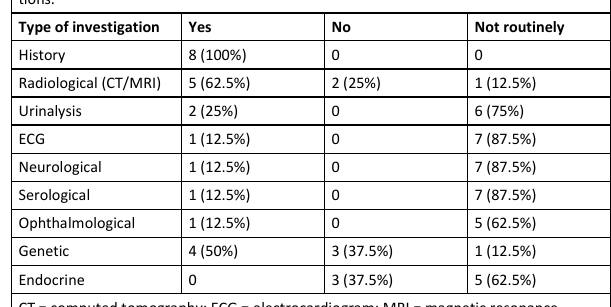
CT = computed tomography; ECG = electrocardiogram; MRI = magnetic resonance